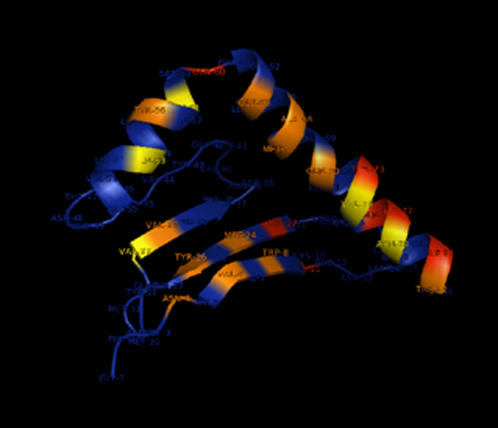
Three-Dimensional Model of the β1 Domain of Cichlid MHC Class II.The tertiary structure prediction was based on Psemmil_m58_c exon 2 sequence (Accession number: EF540049) of 41% homology with mouse MHC sequence gi|13399459 in the Protein Data Bank (http://www.pdb.org/pdb/home/home.do) using the 3D-jigsaw server v.2.0 (http://www.bmm.icnet.uk/~3djigsaw/). The graphical representation was created using the program Pymol v.0.99. Amino acid residues under significant positive selection in Pseudotropheus fainzilberi and P. emmiltos and corresponding to peptide binding sites in humans are highlighted in orange. Residues shown in red were under significant positive selection in P. fainzilberi and P. emmiltos but do not correspond with peptide binding sites in humans. Residues in yellow are human peptide binding sites that were not found to evolve under positive selection in cichlids. The 84 amplified exon 2 codons are numbered 1-84 on the graph. Those correspond to codons 6-89 of the mature protein.